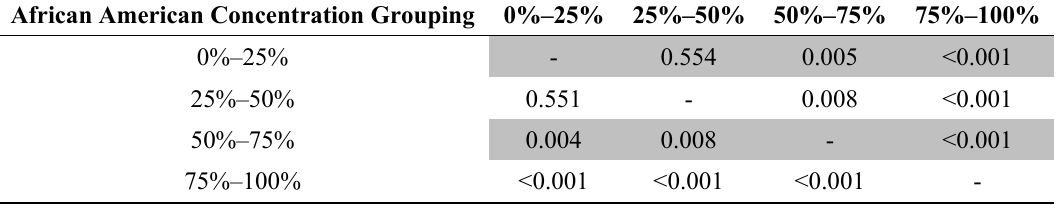
Table 7. P-values of pairwise T-Tests of urban loss within different African American groups (ML in upper triangle, NN at